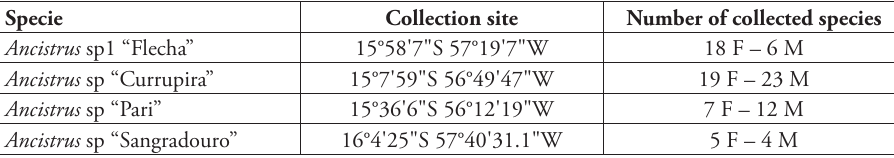
Table 1. Collection site and number of species